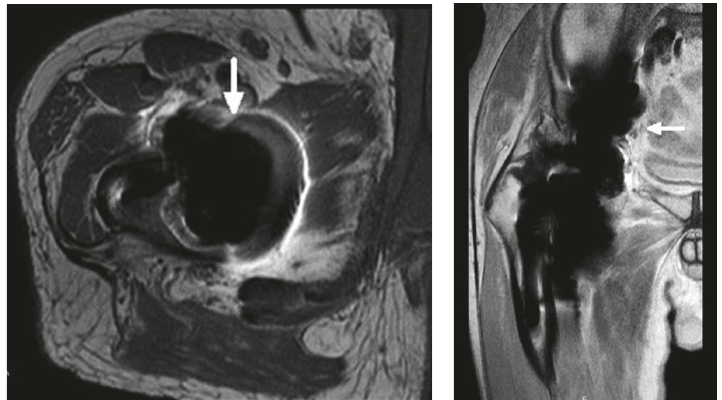
Figure 4: MARS - MRI of the right hip with metal wear debris with comprehensive pseudotumor formation